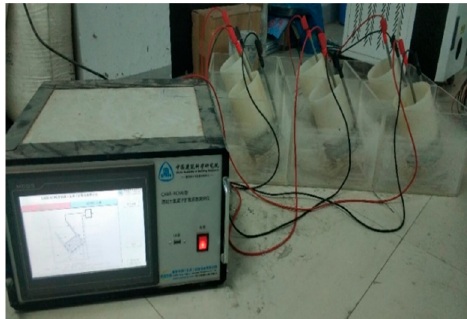
Figure 9. Overall device of the test.